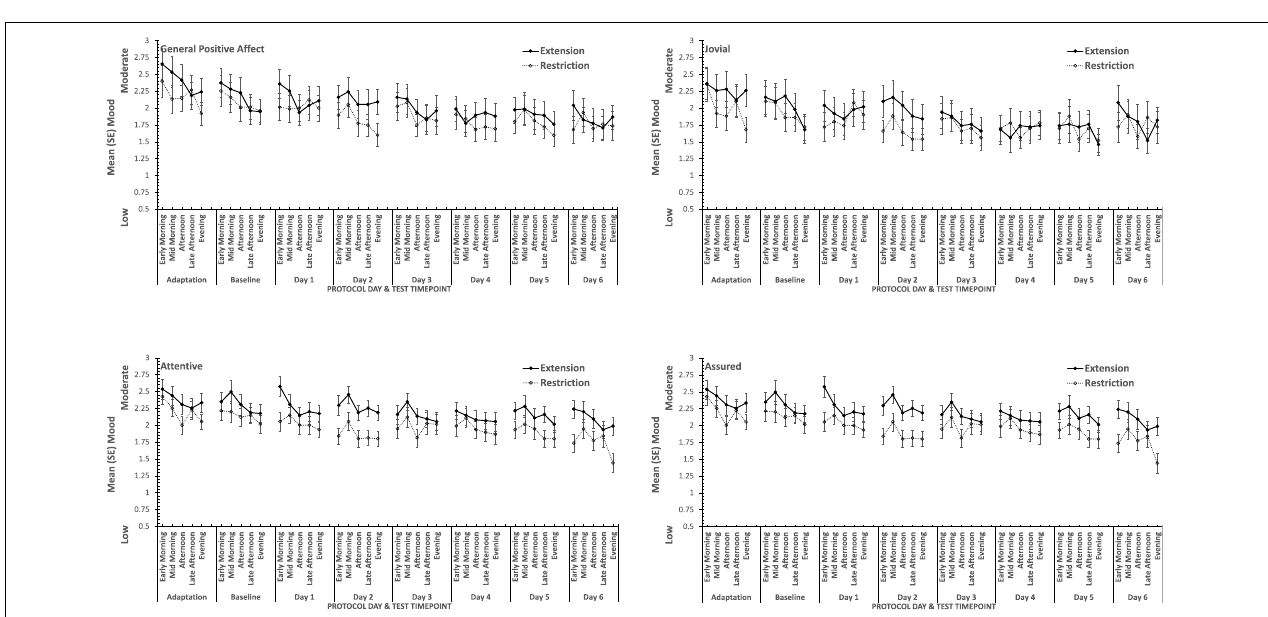
FIGURE 4 | Effects of sleep restriction and extension on Positive Mood (General Positive Affect, Assuredness, Joviality, Attentiveness) across protocol days and mood assessment time points.